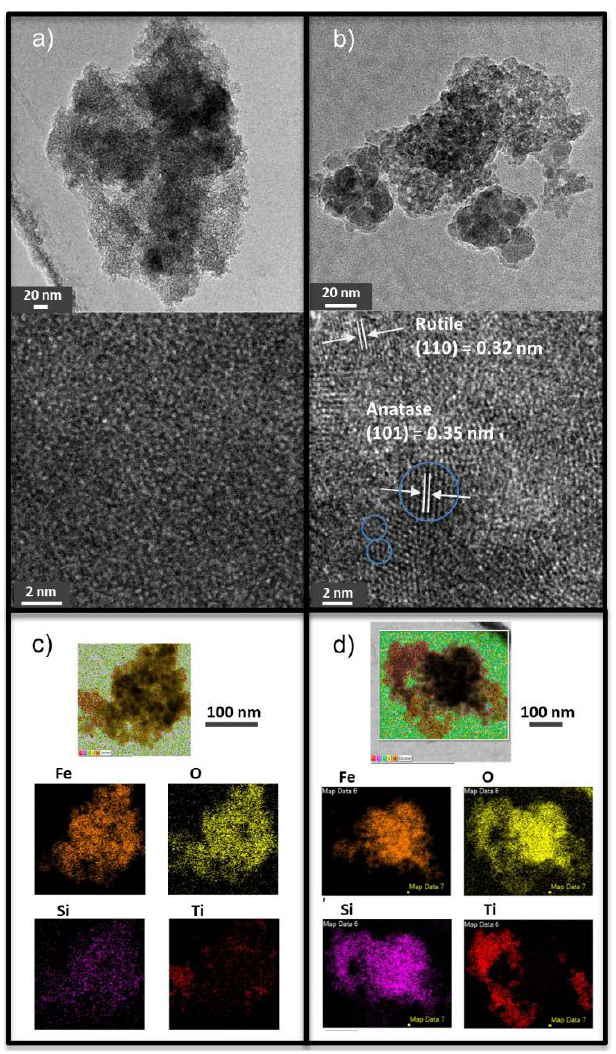
Figure 3. The high-resolution TEM images of MS-TiO 2 -10 nanocomposite: ( a ) as-prepared, and ( b ) annealed at 300 °C. Blue circles show examples of some small anatase crystallites. The EDS elemental mapping of the MS-TiO 2 -10 nanocomposite samples: ( c ) as-prepared, and ( d ) annealed at 300 °C.